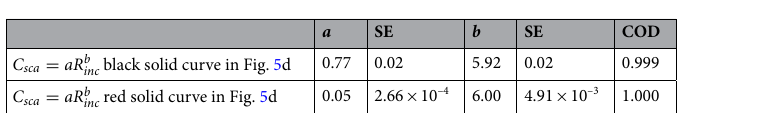
particles was then evaluated. By substituting the fitting curve in Fig. 3c of R inc = 0.0047 × I 0.75358 + 1 into C sca = R 6 C sca ( R = 6 was obtained (black dashed curve in Fig. 3d). By comparing the inc ) inc , experimental results (solid red squares in Fig. 3d) with calculated C sca (black dashed curve in Fig. 3d) for 808 nm light irradiation, the Ag deposition rate was far below the plasmonic field enhancement effect (black dashed curve in Fig. 3d). Therefore, we concluded that the observed Ag deposition by illumination with 808 nm light originated from the NF-assisted SHG (Fig. 1c) and subsequent excitation of n − π ∗ transitions for the photocleavage of C–P bonds. Note that NF-assisted SHG does not yield the same results as when using a high-power laser (~ 10 9 W/ cm 2 ) 26 , because a continuous laser with low power density (~ 1 W/cm 2 ) was employed. In addition, because the wavelength of 808 nm for the NF-assisted process was far from the plasmon resonance wavelengths of 520 nm (Au) and 345 nm (Ag), the plasmon-induced SHG process 27 can be excluded.